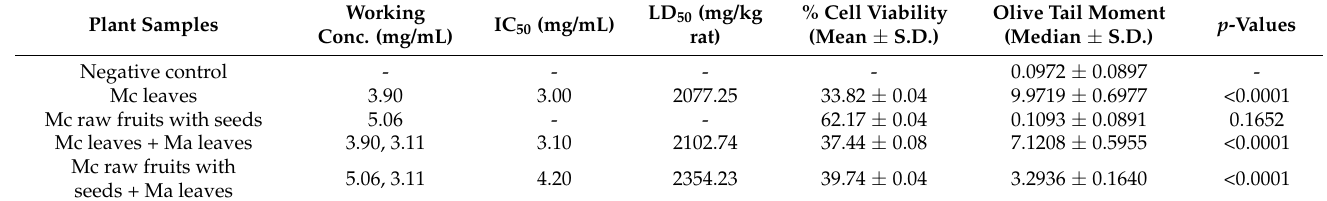
Figure 6. Inhibition gene expression values and the mixture of plant parts with various concentrations of Morinda citrifolia (Mc) containing α -EG and pinoresinol, and Morus alba (Ma) leaves containing 20.48 g total protein per 100 g at a concentration of 3.11 mg/mL.